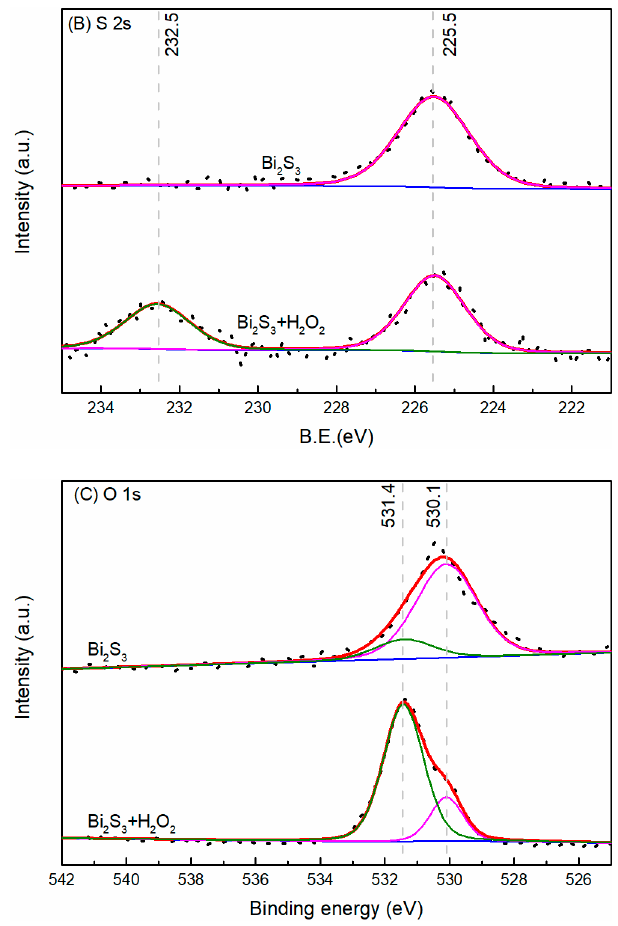
Figure 14. XPS spectra of bismuthinite: ( A ) Bi 4 f , ( B ) S 2 s , ( C ) O 1 s . Dots represent the experimental spectrum, heavy red solid lines indicate the best fit curve, and the individual XPS peaks are shown as thin solid lines in different colors.